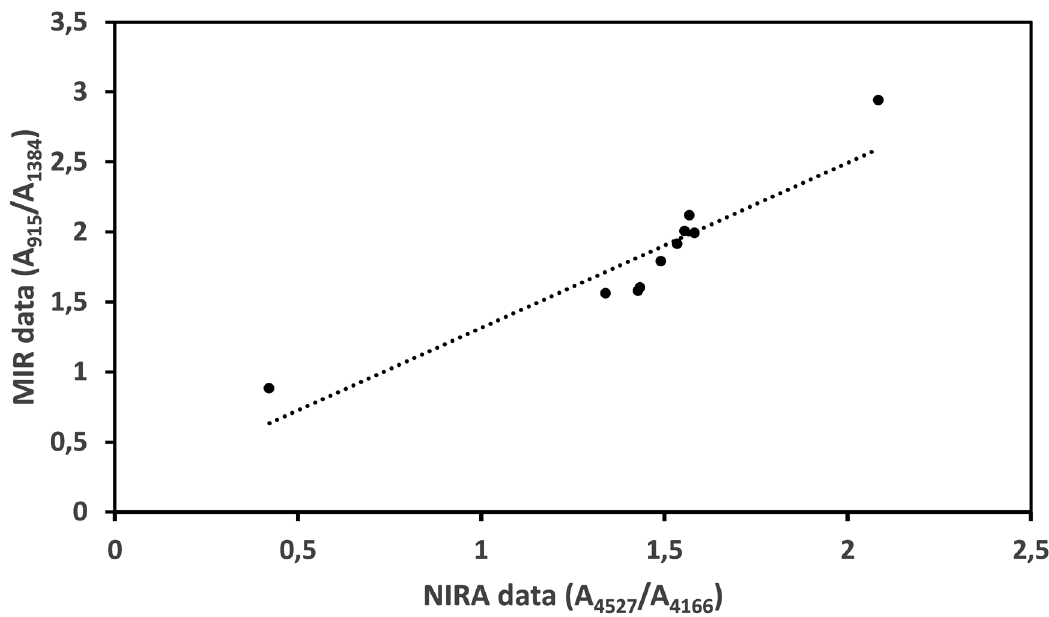
Figure 7. MIR absorbance values of relative band A used to estimate the content of epoxide groups reacted in the EP/n-SH/DETA (5:5:0.1) system at 122 o